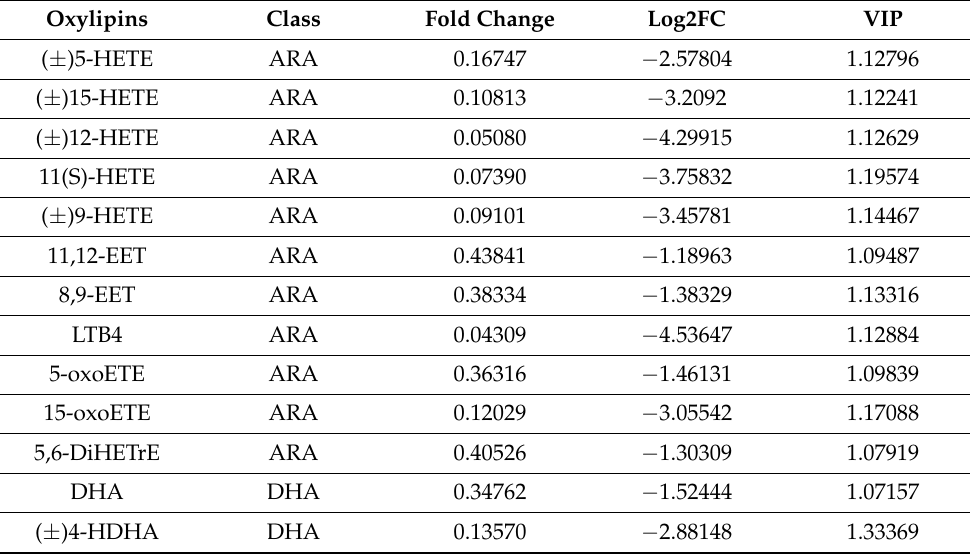
Figure 4. The quantitative content of ARA derived differential oxylipins in feces ( n = 10). ( a ) the quantitative content of ARA in feces of suckling piglets at birth day 3 and day 21. ( b ) the absolute levels of ARA derived differential oxylipins. ( c ) KEGG pathway analysis of the ARA derived differential oxylipins in feces at 3 and 21 days after birth. Blue indicates that substances were detected but had no significantly change compared to these of 21d, and green indicates that the content of oxylipins was significantly down-regulated in feces from 21 days after birth. Table 2. Differential oxylipins in feces at 3d and 21d